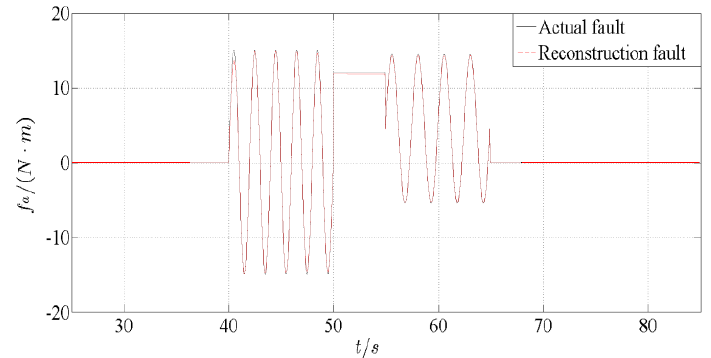
Figure 7. Actual and reconstructed values of actuator fault f a.